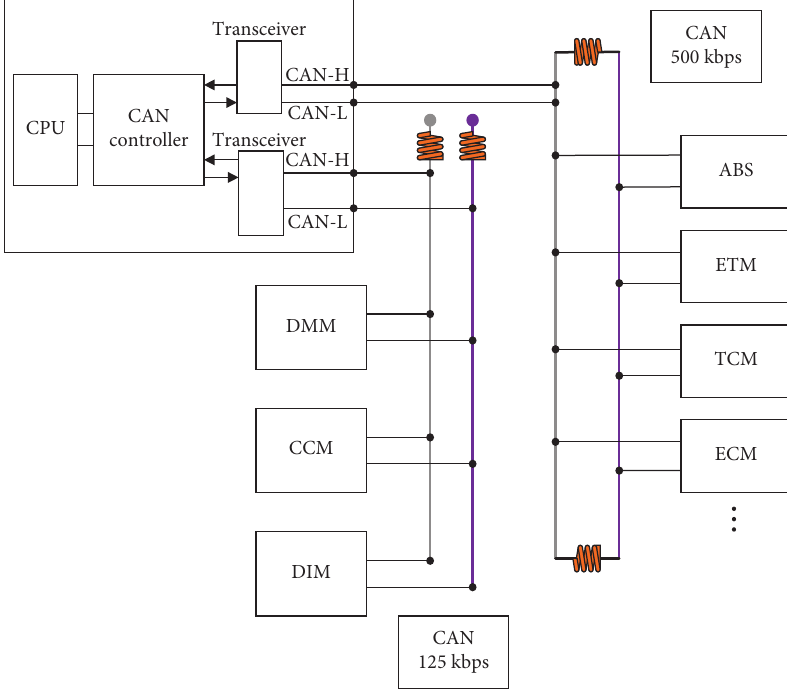
Figure 5: Typical CAN bus connection diagram. Table 1: Parameter information of engine based on SAE J1939